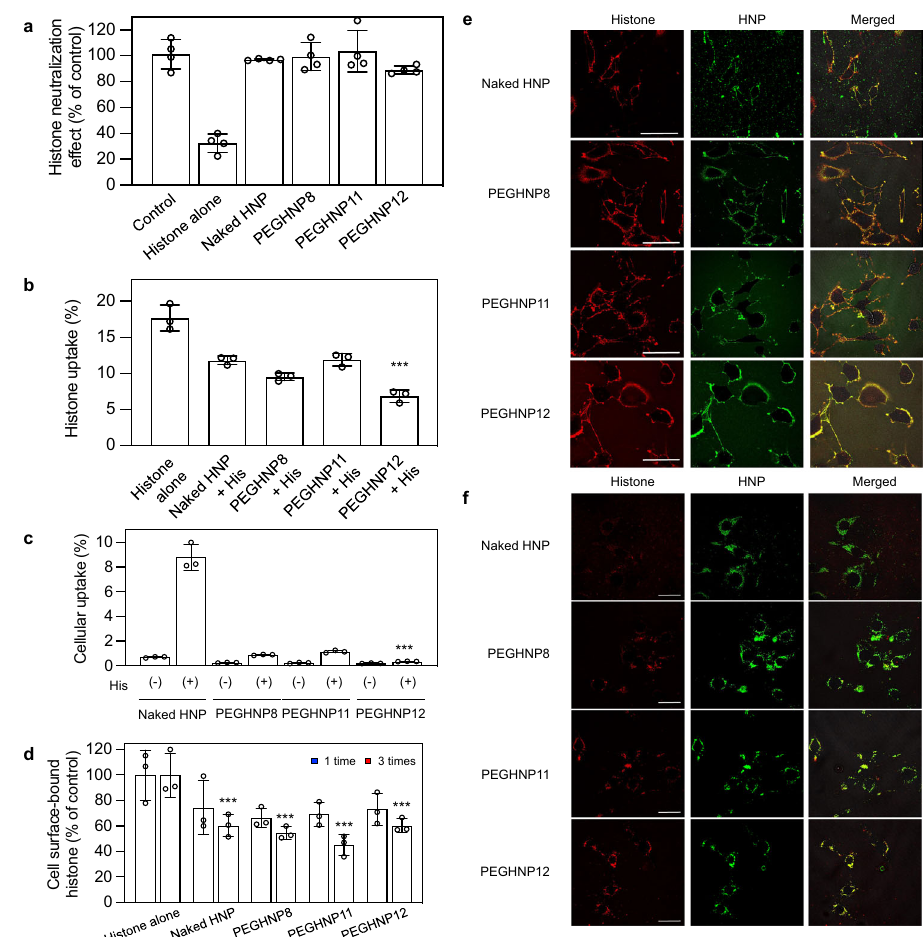
Fig. 4 Neutralization of histones by HNPs after their binding to the cell surface. a Neutralization of the cell surface-bound histones by PEGHNPs. 2H-11 cells were treated with histones for 60 s. Then, PEGHNPs were added after the PBS washing to remove free histones in the medium. At 24 h after HNP addition, viable cells were determined by a WST-8 assay. Data represent the means ± s.d. n = 4. b Cellular uptake of histones. 2H-11 cells were incubated with Cy5-histones and PEGHNPs for 24 h. Then, the cells were lysed and the amount of Cy5-histones was measured. Signi fi cant difference; *** p < 0.0001 vs. Histones alone, p = 0.0012 vs. Naked HNP + His, p = 0.062 vs. PEGHNP8 + His, and p = 0.0001 vs. and PEGHNP11 + His. Data represent the means ± s.d. n = 3. Differences within a group were evaluated by one-way analysis of variance (ANOVA) with the Tukey post hoc test using Kaleidagraph (Version 4.5.3). c Cellular uptake of HNPs. 2H-11 cells were incubated with FITC-HNPs and/or histones for 24 h. Then, the cells were lysed and the amount of FITC-HNPs was measured. Signi fi cant difference; *** p < 0.0001 vs. Naked HNP( + ), p = 0.0001 vs. PEGHNP8 ( + ), and p < 0.00012 vs. PEGHNP11 ( + ). Data represent the means± s.d. n = 4. The data were analyzed by two-tailed Student ’ s t tests. d Removal of the cell surface-bound histones by PEGHNP washing. 2H-11 cells were treated with Cy5-labeled histones for 10 s. The cells were washed with PEGHNPs 1 or 3 times. Then, the cells were lysed and the fl uorescent intensity of Cy5-histones was measured. Signi fi cant difference; p = 0.046 Histone alone vs. Naked HNP, p = 0.046 Histone alone vs. PEGHNP8, p = 0.046 Histone alone vs. PEGHNP11, and p = 0.026 Histone alone vs. PEGHNP12. Data represent the means± s.d. n = 3. The data were analyzed by two-tailed Student ’ s t tests. e , f Localization of Cy5-histones and FITC-PEGHNPs. 2H-11 cells were treated with Cy5-histones for 10 s. Then, the cells were washed with FITC-PEGHNPs. At 30 min ( e ) and 24 h ( f ) after the washing, the localization of Cy5-histones and FITC-HNPs was observed laser scanning confocal microscopy. Red: histones; Green: HNPs; Bar: 50 µ m. The experiment was repeated two times and three pictures were taken in each